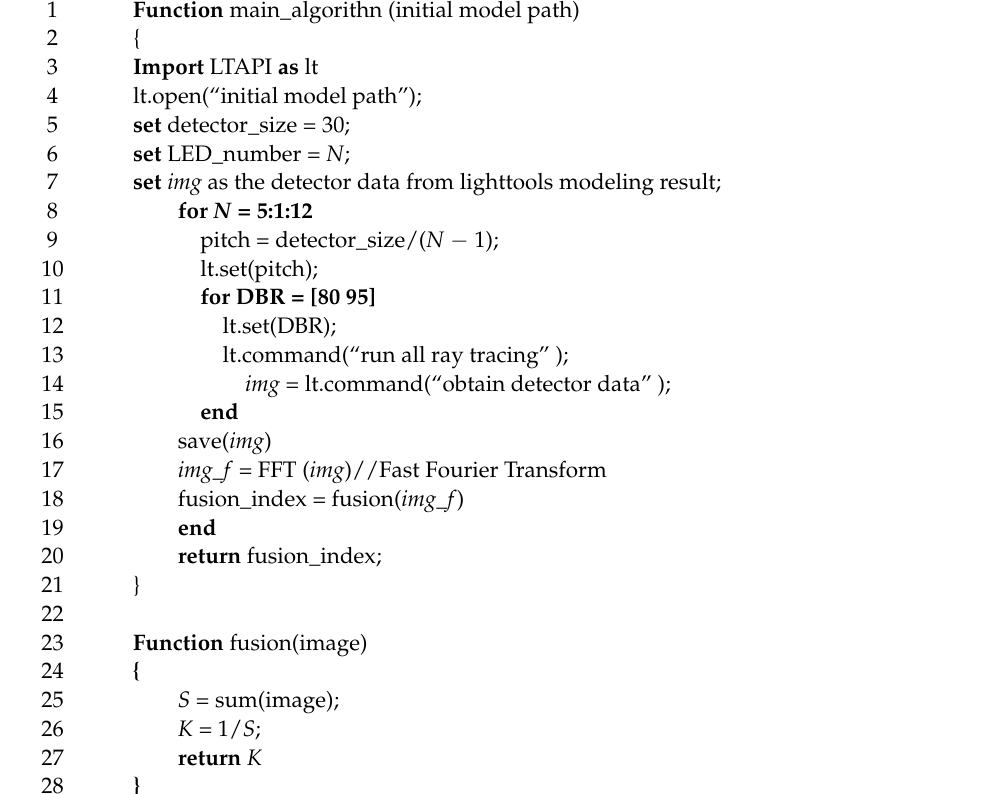
Algorithm 1: Algorithm to obtain fusion